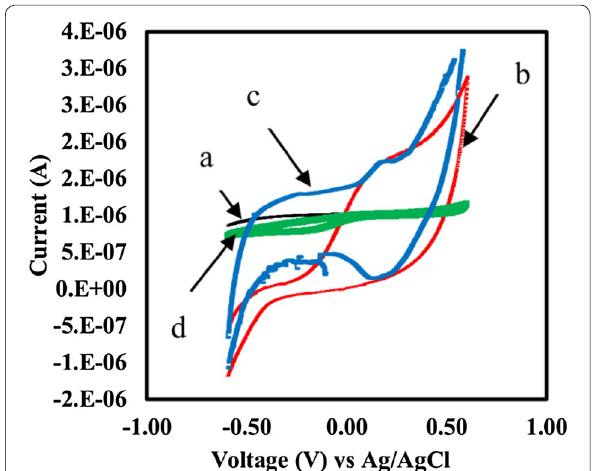
Fig. 3 Cyclic voltammograms of anodic biofilms of MFCs on day 40. RHCE: (black line) MFC 1, (red line) MFC 2, (blue line) MFC 3. CCE: (green line) MFC 2. The peak areas, amongst the MFC treatments are shown in the following order: RHCE- MFC 2 (red line) > RHCE-MFC 3 (blue line) > RHCE-MFC 1 (black line) > CCE-MFC 2 (green line). The peak redox areas of RHCE-MFC 1 (black line) and CCE-MFC 2 (green line) showed poor electrochemical